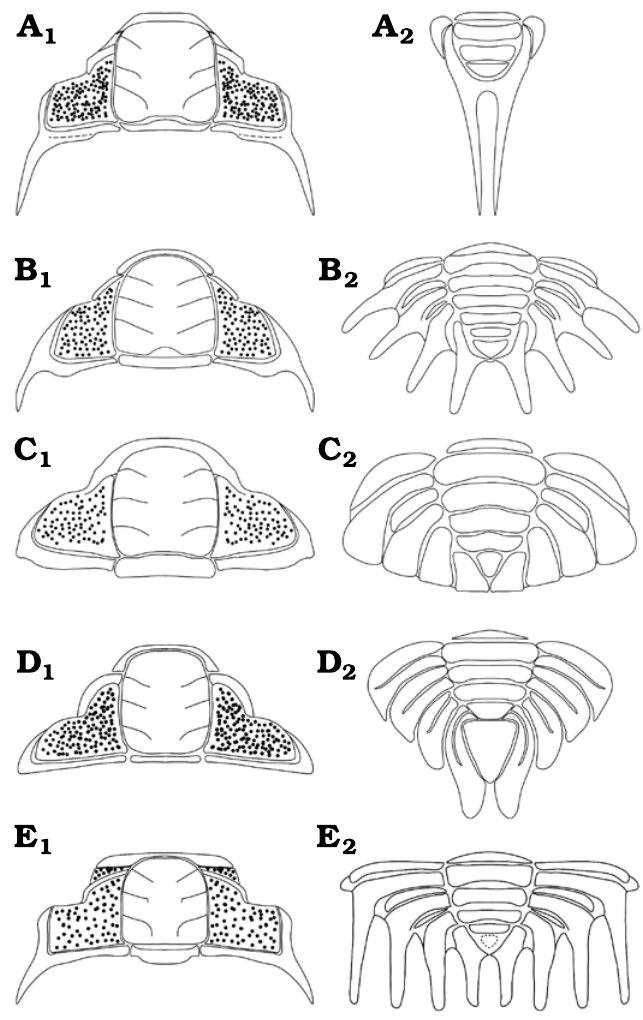
Fig. 8. Reconstructions of cranidia (A 1 –E 1 ) and pygidia (A 2 –E 2 ) of differ- ent members of the subfamily Pilekiinae. A . Anacheirurus adserai (Vela and Corbacho, 2008). B . Parapilekia olesnaensis (Růžička, 1935), based on Mergl (2006). C . Tesselacauda depressa Ross, 1951, based on Adrain and Karim (2019). D . Landyia elizabethae Jell, 1985, based on Jell (1985). E . Macrogrammus rafi Edgecombe, Chatterton, Vaccari, and Waisfeld, 1999, based on Edgecombe et al.